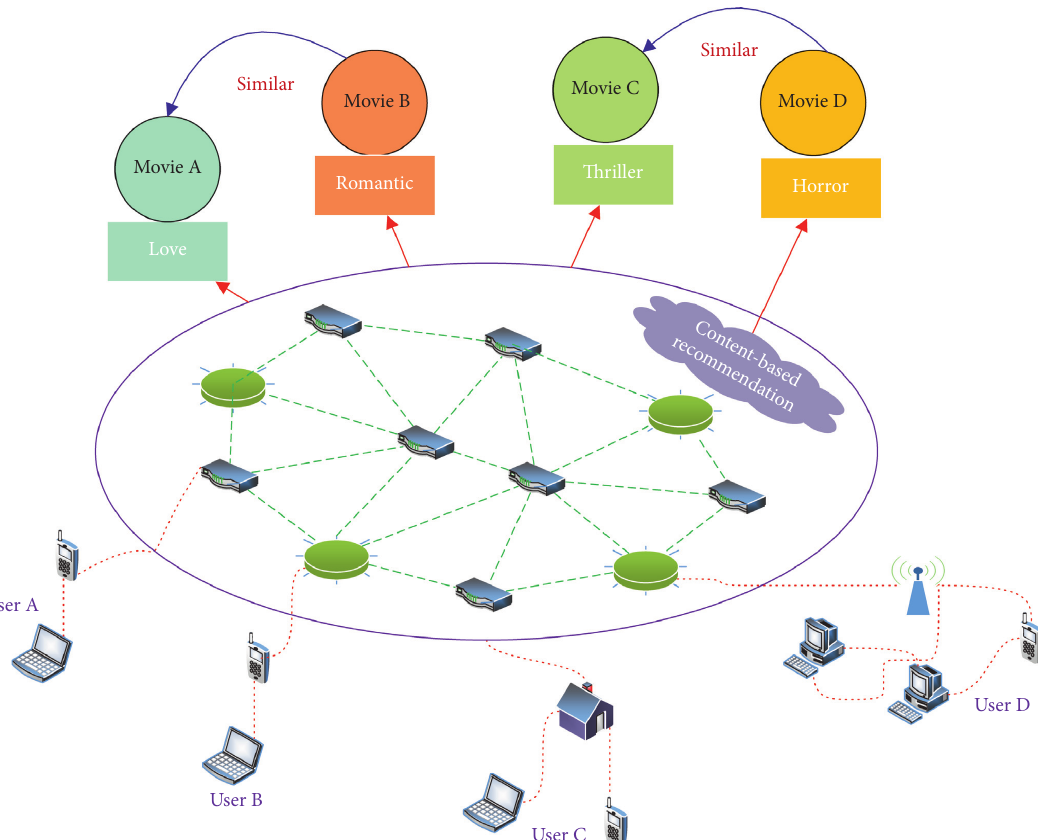
Figure 1: Content-based recommendation principle.